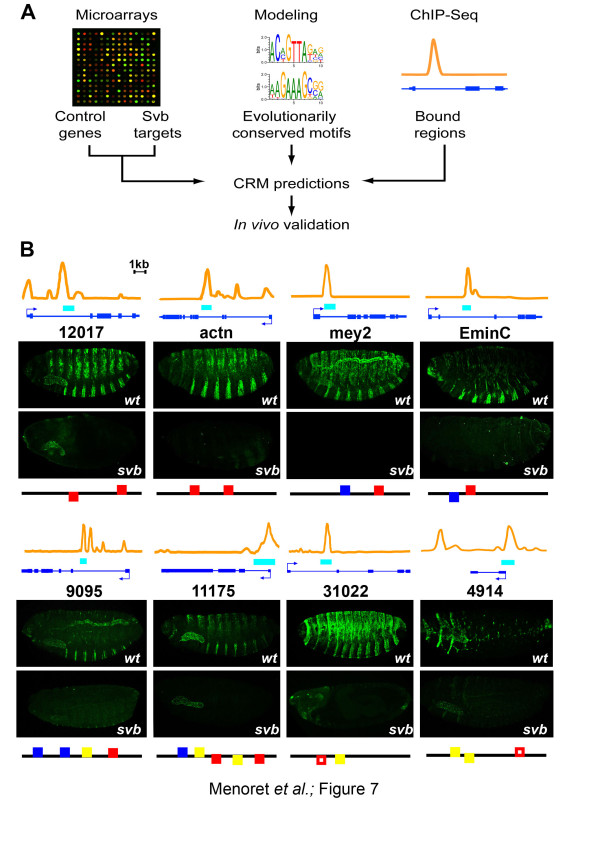
Identification of Svb direct targets and their trichome enhancers using computational and in vivo experimental approaches. (a) Flow diagram summarizing the pipeline used for enhancer prediction and validation. (b) Motif distribution coupled to ChIP-seq allows prediction of location of enhancers in Svb downstream targets. Graphs show ChIP intensity at the time of trichome formation (12 to 14 h of embryogenesis). Active enhancers are drawn as cyan rectangles. Pictures show reporter gene expression driven by corresponding regions in wild-type (wt) and svb mutant embryos, as revealed by anti-lacZ immunostaining (green). The composition, orientation and respective positioning of svbF7 (red), blue and yellow motifs is schematized by filled (evolutionarily conserved) and open (not traceable across species) boxes.